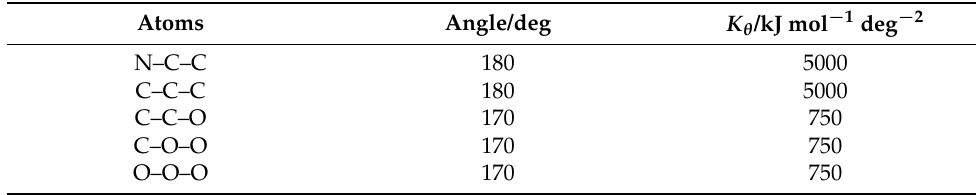
Table 3. Angle parameters for CG models of